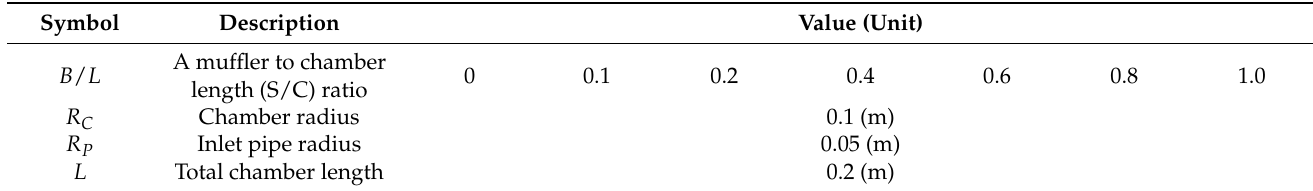
Table 2. The parameters’ specific values of the DCLCM model used for acoustical analysis.